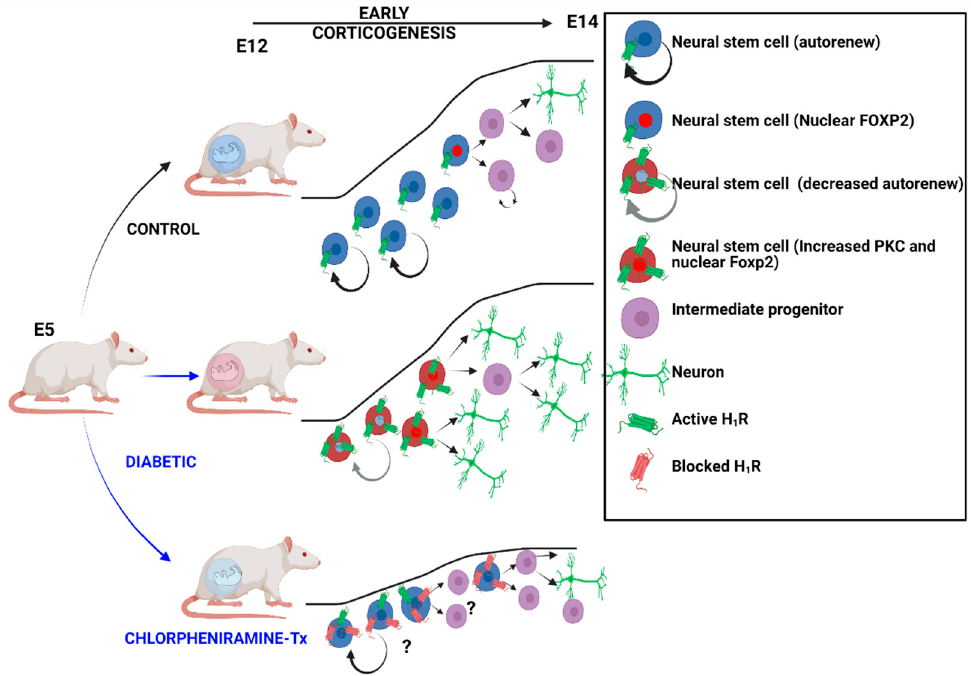
Figure 8. Scheme of the impaired neurogenesis of embryos from diabetes diabetic rats and the effect of H 1 R blocking. Data obtained in the present study and Solís et al., 2017. Created with BioRender.com (5 August 2022).